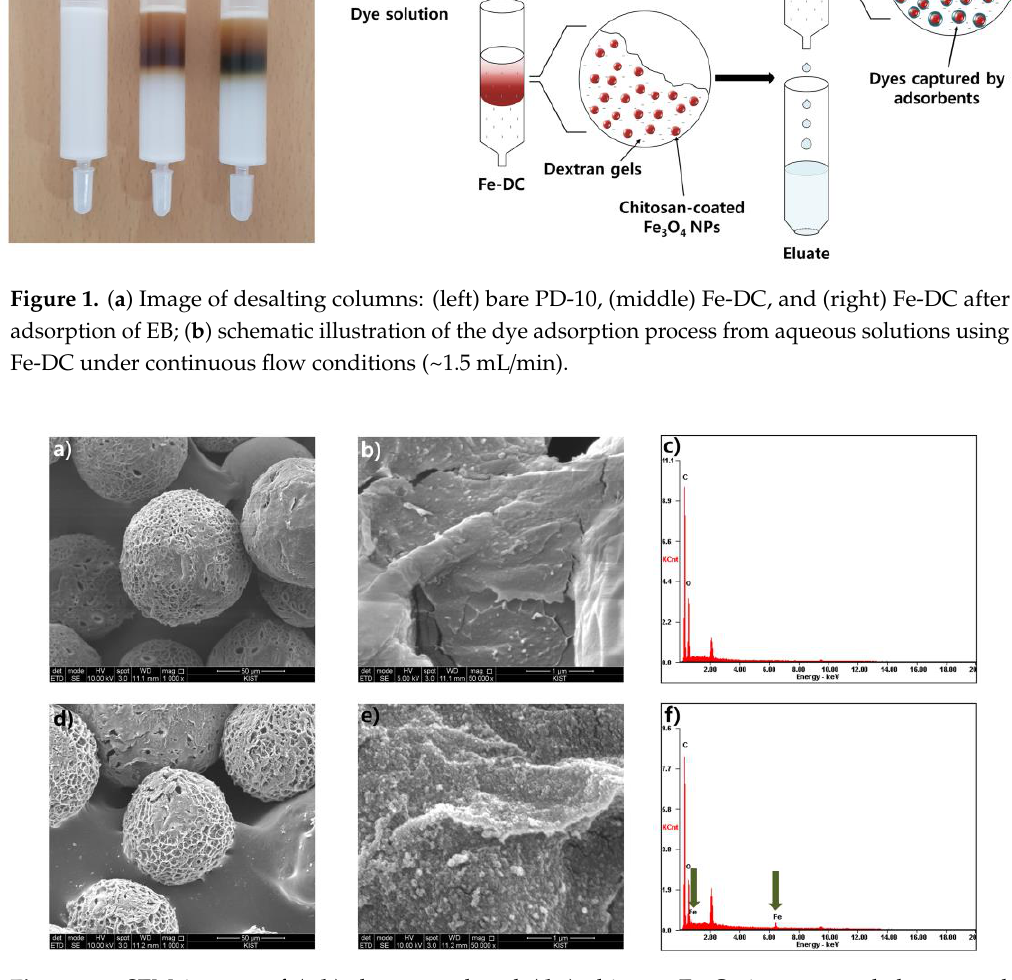
Figure 2. SEM images of ( a,b ) dextran gel and ( d,e ) chitosan-Fe 3 O 4 -incorporated dextran gel. EDX analysis of ( c ) dextran gel and ( f ) chitosan-Fe 3 O 4 -incorporated dextran gel; arrows indicate the presence of iron.